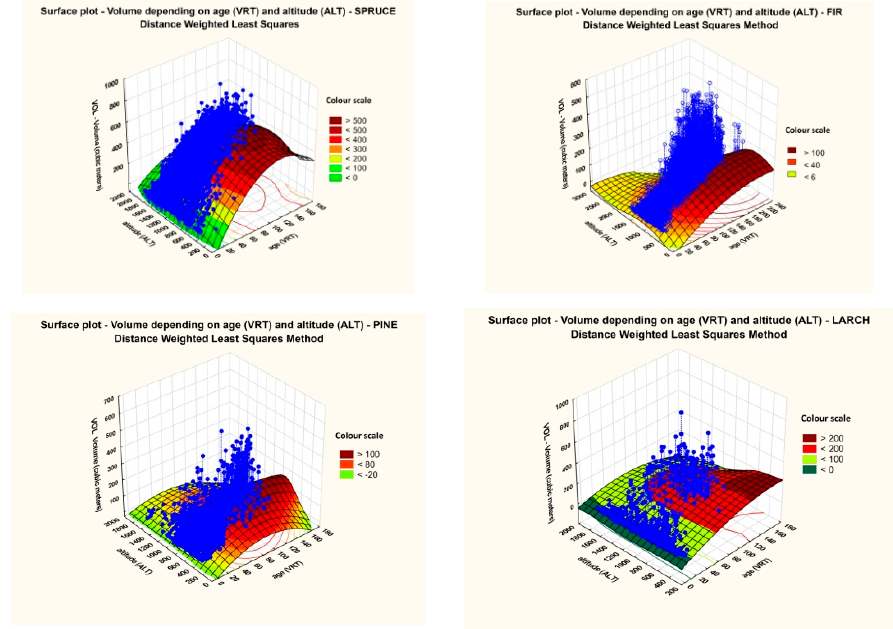
Figure 16. Three-dimensional VOL diagram based on VRT and ALT. The diagram from Figure 16 represents the dependencies between volume (pictured on the vertical axis), altitude (ALT, meters), and age (VRT, years).